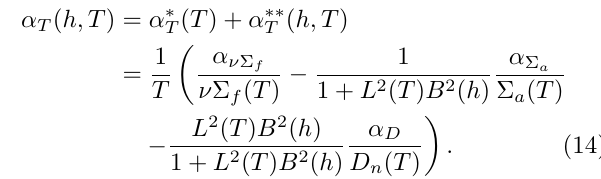
Fig. 4. Temperature feedback coefficients as function of temperature. The coefficient α ∗∗ length h